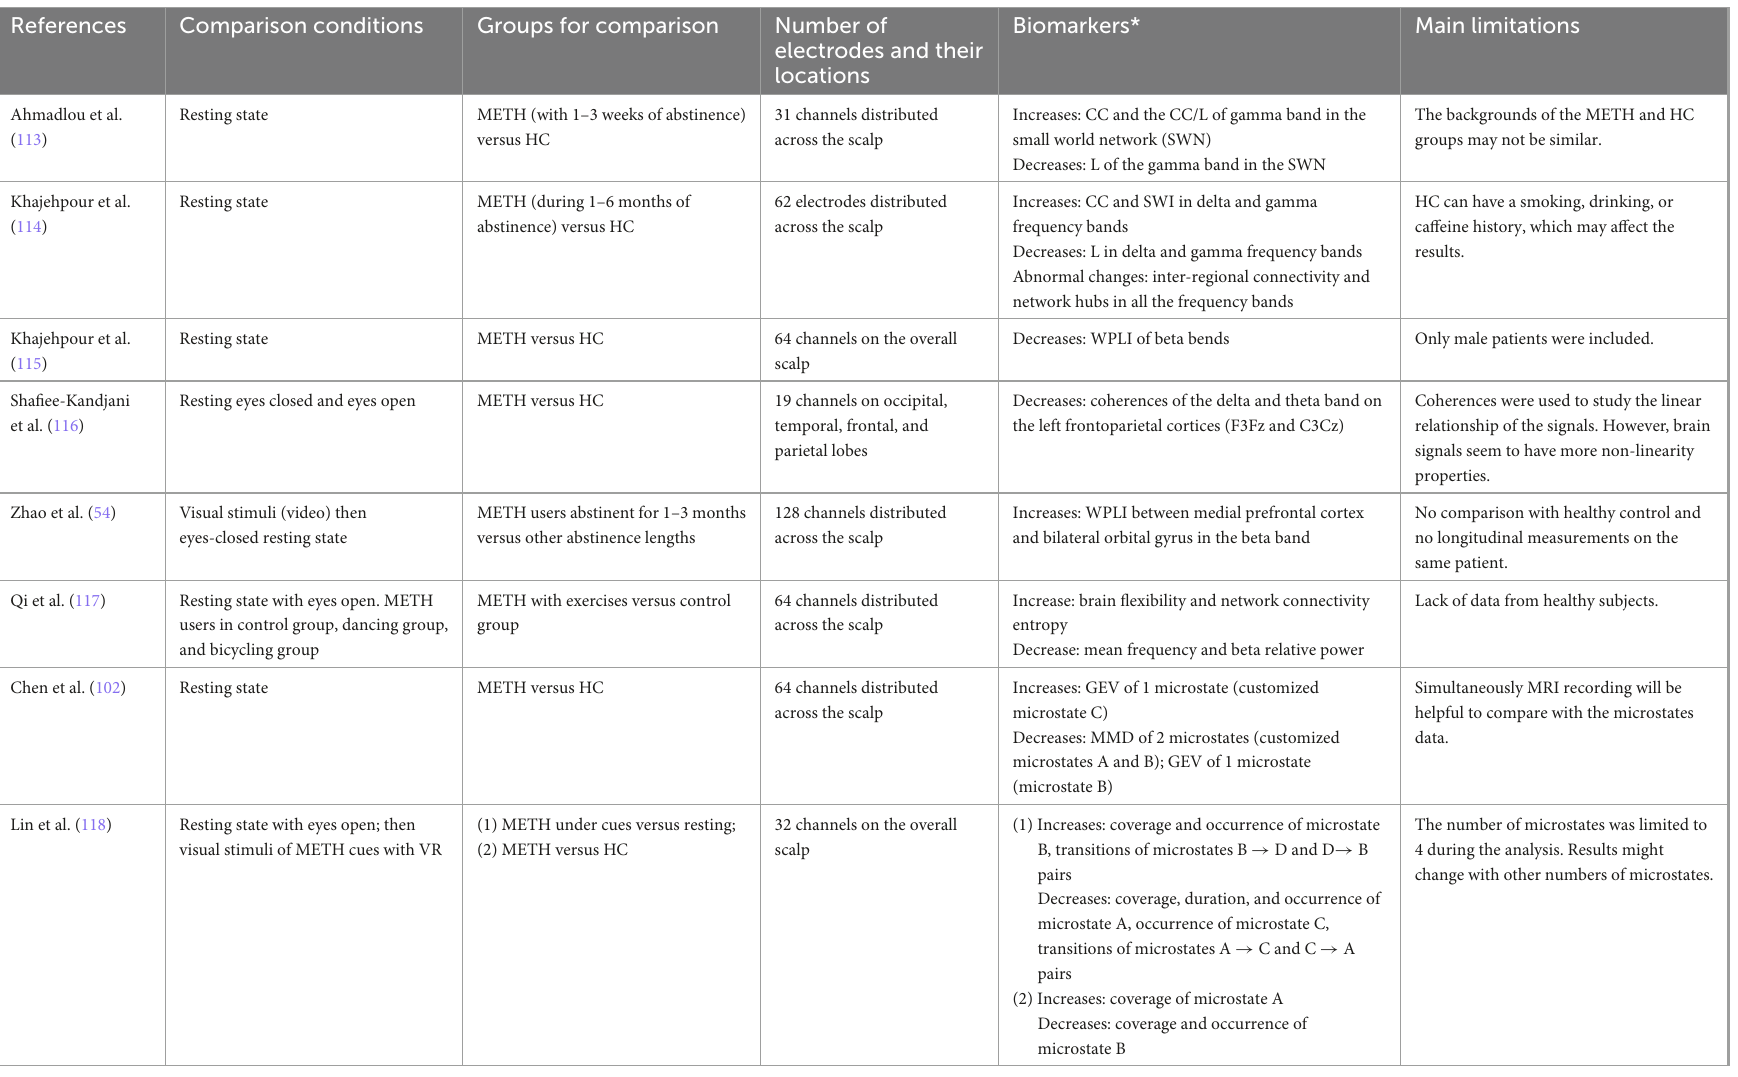
TABLE 2 Biomarkers of EEG signals in functional connectivity (FC) network and network topological properties on patients with METH